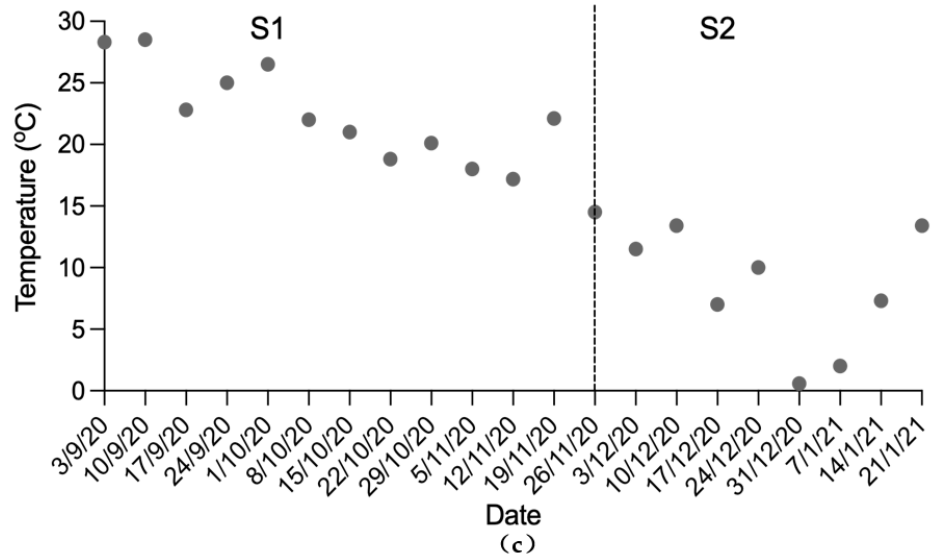
Figure 2. Variations of DO, ORP and temperature in the influent and effluent of the six plots. ( a ) DO; ( b ) ORP; ( c ) Temperature (T) . The experiment was divided into two stages: S1 (T ≥ 15 °C) and S2 (T < 15 °C).